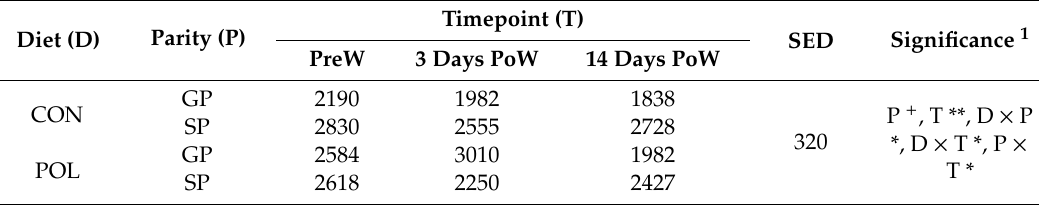
Table 3. The e ff ect of parity (gilt progeny (GP) vs. sow progeny (SP)), diet (control, CON vs. 0.5% dietary Polygain, POL) and time (pre-weaning, PreW vs. 3 days post weaning, 3 days PoW vs. 14